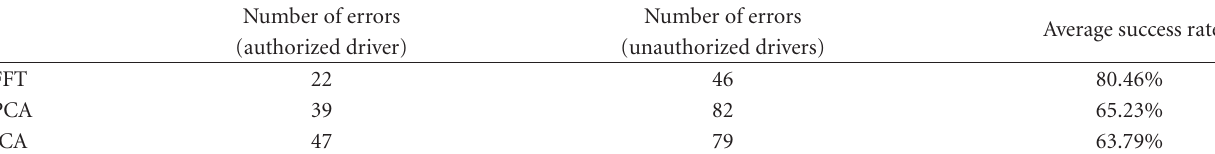
Figure 6: Block diagram of SVMs network classifier. Table 1: Test results using di ff erent preprocessing methods.